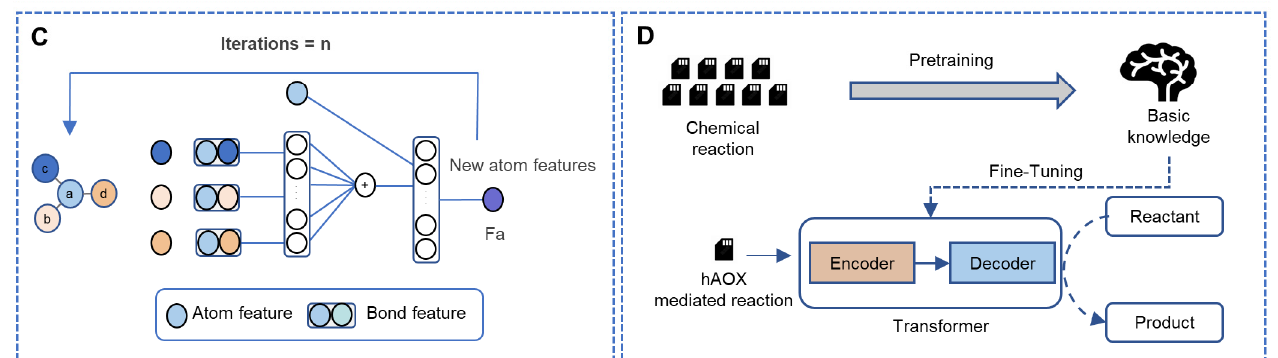
Figure 1. The framework of this study. ( A ) The overview of our work. ( B ) The details of the fingerprint-based method. ( C ) The workflow of the WLN model to obtain the atom environment features. ( D ) The whole workflow of the sequence-based model in this study. (ML: machine learning, GCN: graph convolutional network, VT: variance threshold, SPF: select percentile of feature, PCA: principal component analysis, RF: random forest, SVM: support vector machines, GBDT: gradient boosted decision trees.)